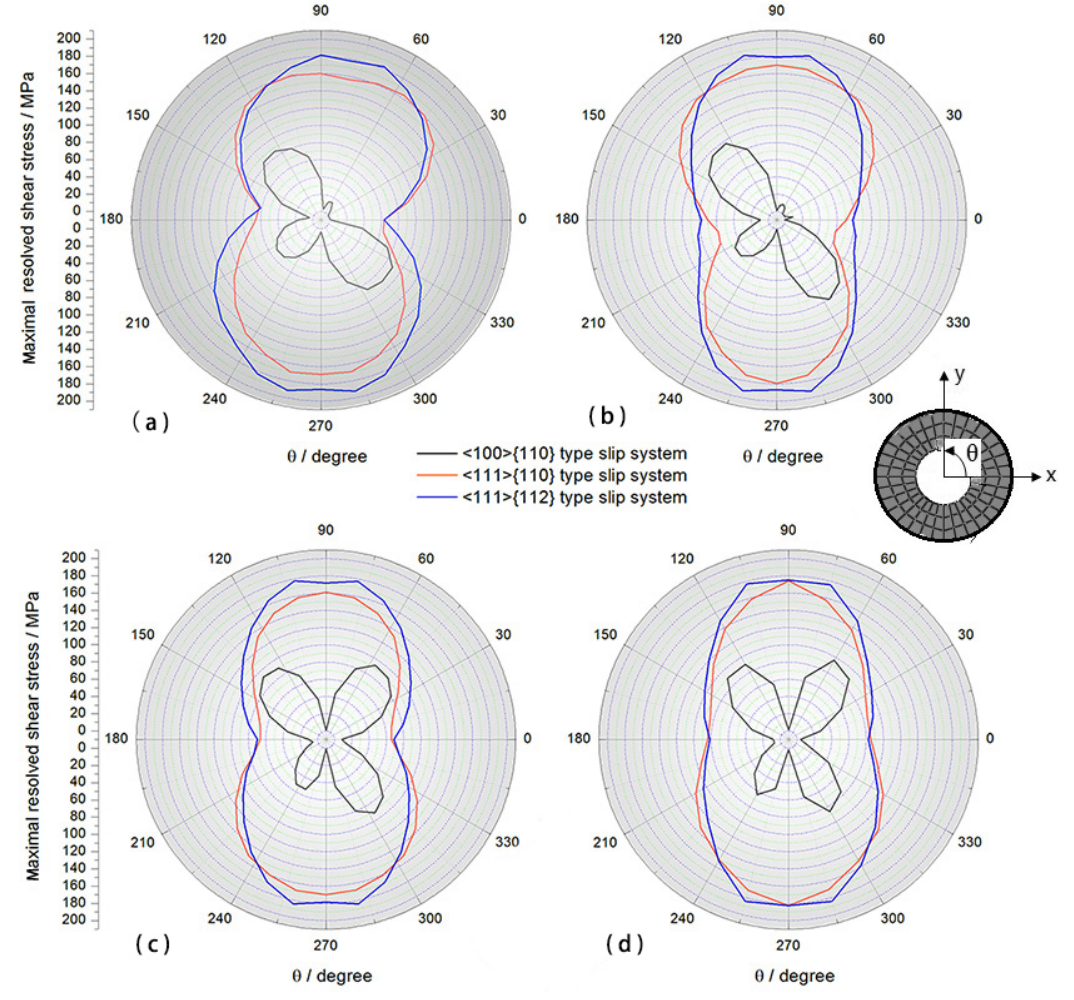
Figure 10. Numerical results of the maximal resolved shear stress at the edge of different film-holes shown in Figure 7: ( a ) H1; ( b ) H2; ( c ) H3; ( d )